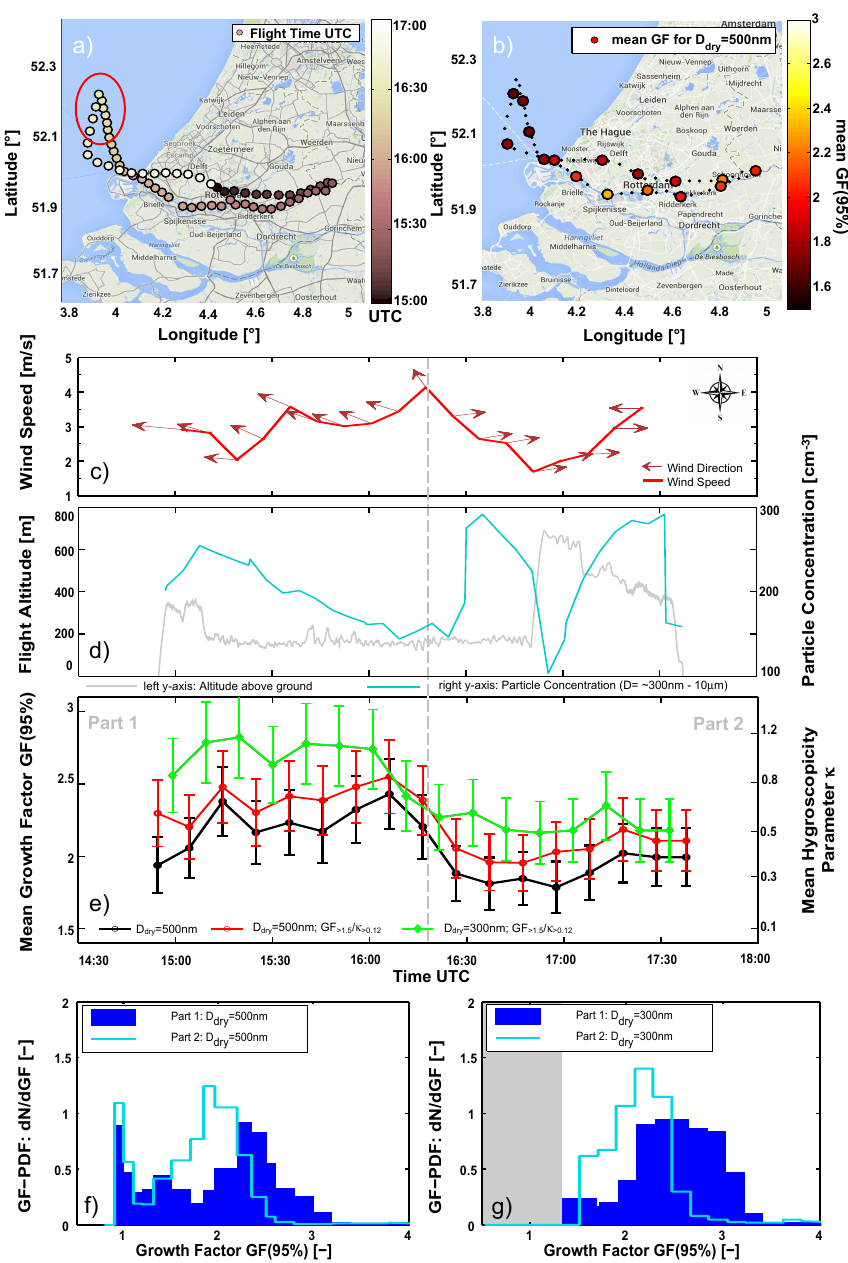
Figure 12. Example of airborne WHOPS measurements on board the Zeppelin NT from 22 May 2012 in the Netherlands; (a) flight track color coded by UTC time; (b) mean GFs (color coded) at RH = 95% for D dry =500nm particles; (c) time series of the local wind speed (red curve) and wind direction (red arrows) measured on board the Zeppelin NT; (d) time series of the flight altitude (gray line) and number concentration of particles with D > 300nm measured by the polydisperse WELAS1 (turquoise line); (e) time series of the measured mean GF (left axis) and corresponding κ values (right axis) for the selected particle size of 500nm; additionally the mean GF of all particles with GF > 1.5 ( κ > 0.12; lower detection limit when selecting 300nm particles) is shown for the 300nm and 500nm particles; the gray dashed line across panels (c) , (d) and (e) marks the point in time when the local wind direction changed between the first and second part of the flight; (f) GF-PDF for humidified 500nm particles separately averaged over “Part 1” and “Part 2”; (g) equivalent to (f) but showing results for 300nm particles; the gray area covers the GF range that cannot be reliably detected for this particle